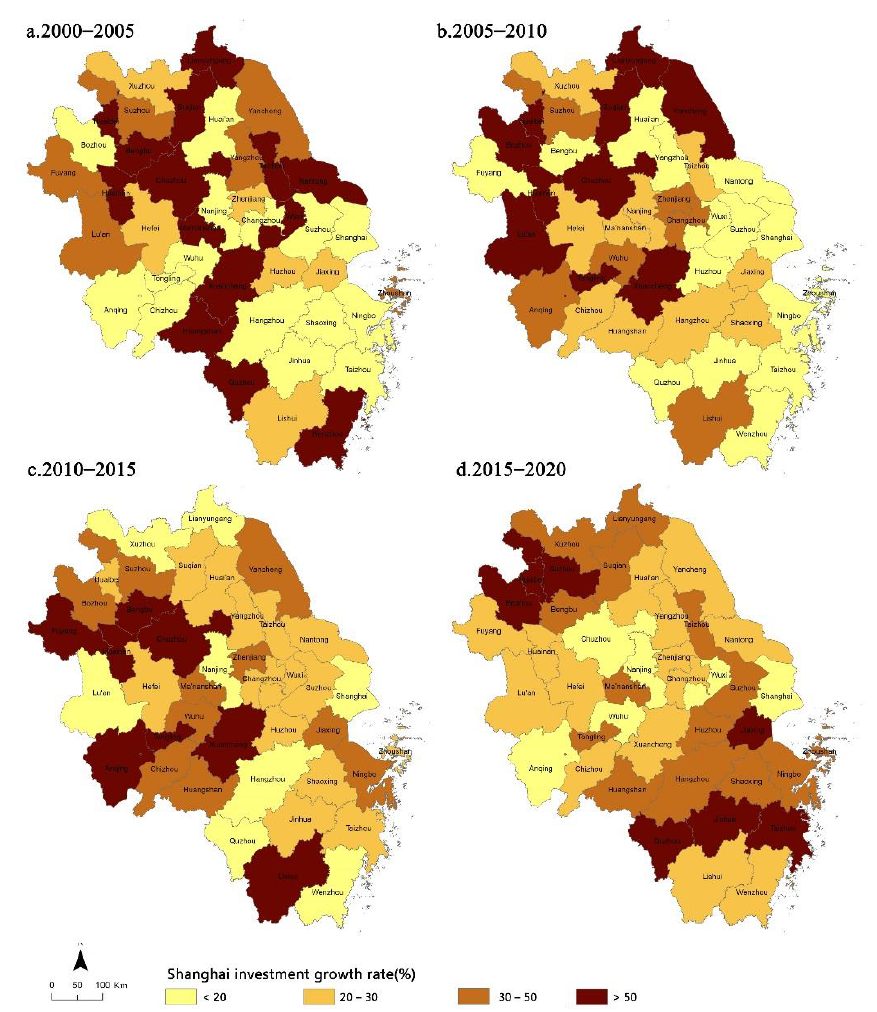
Figure 4. Shanghai’s investment growth rate in cities in the YRD from 2000 to 2020.